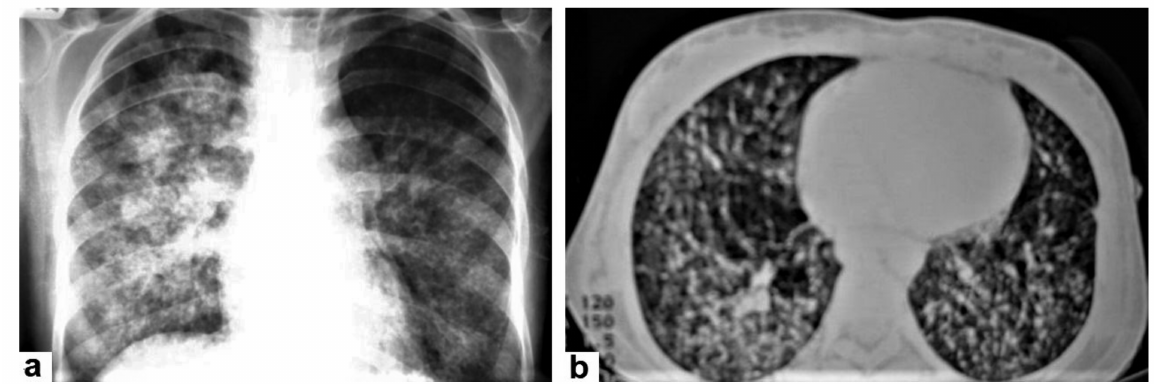
Figure 6. Miliary TB in an 18-year-old man (same patient of Figure 1). ( a ) Chest radiograph shows superimposed innumerable small nodules in lungs right greater than the left predominantly affecting lung bases due to gravity-dependent high blood flow. ( b ) Axial chest CT shows innumerable small (1–3 mm) nodules with random distribution in both lung fields.